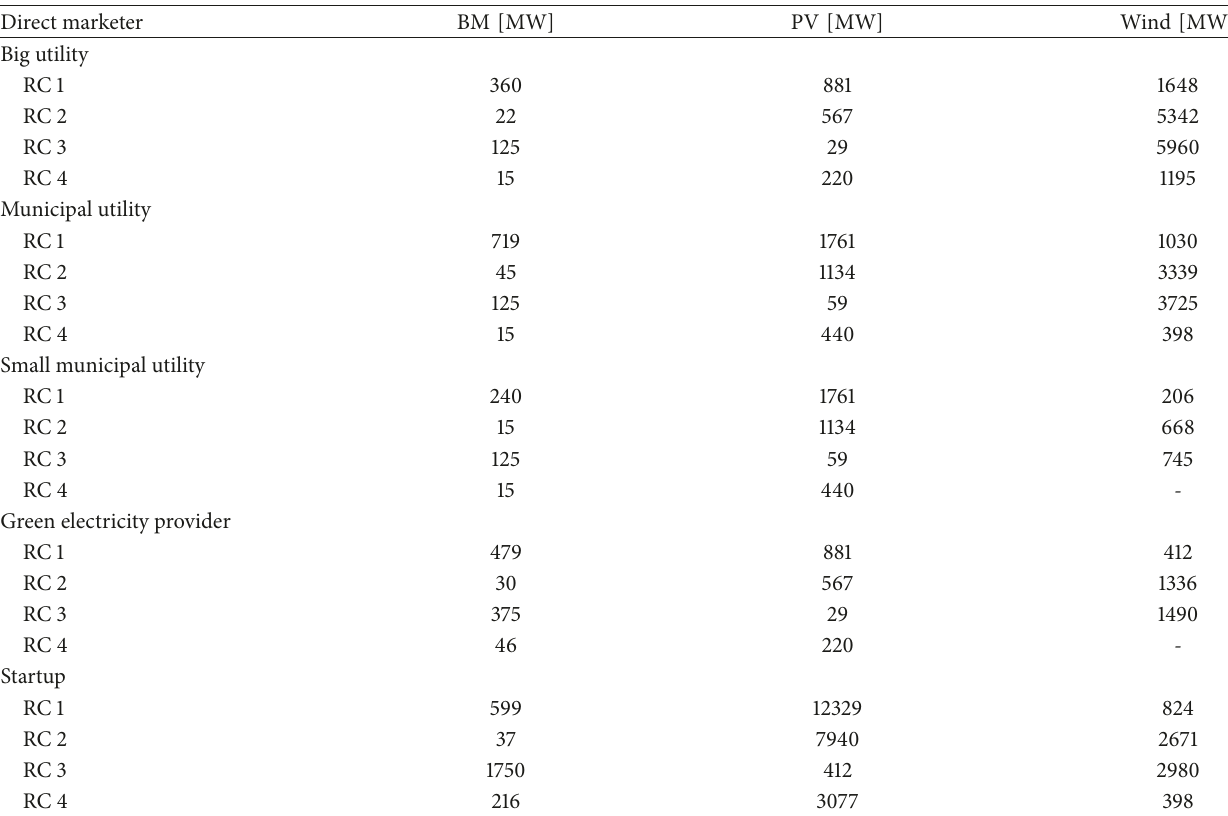
Table 9: Installed capacity per remuneration class as assigned to the marketers at the beginning of simulation. Direct